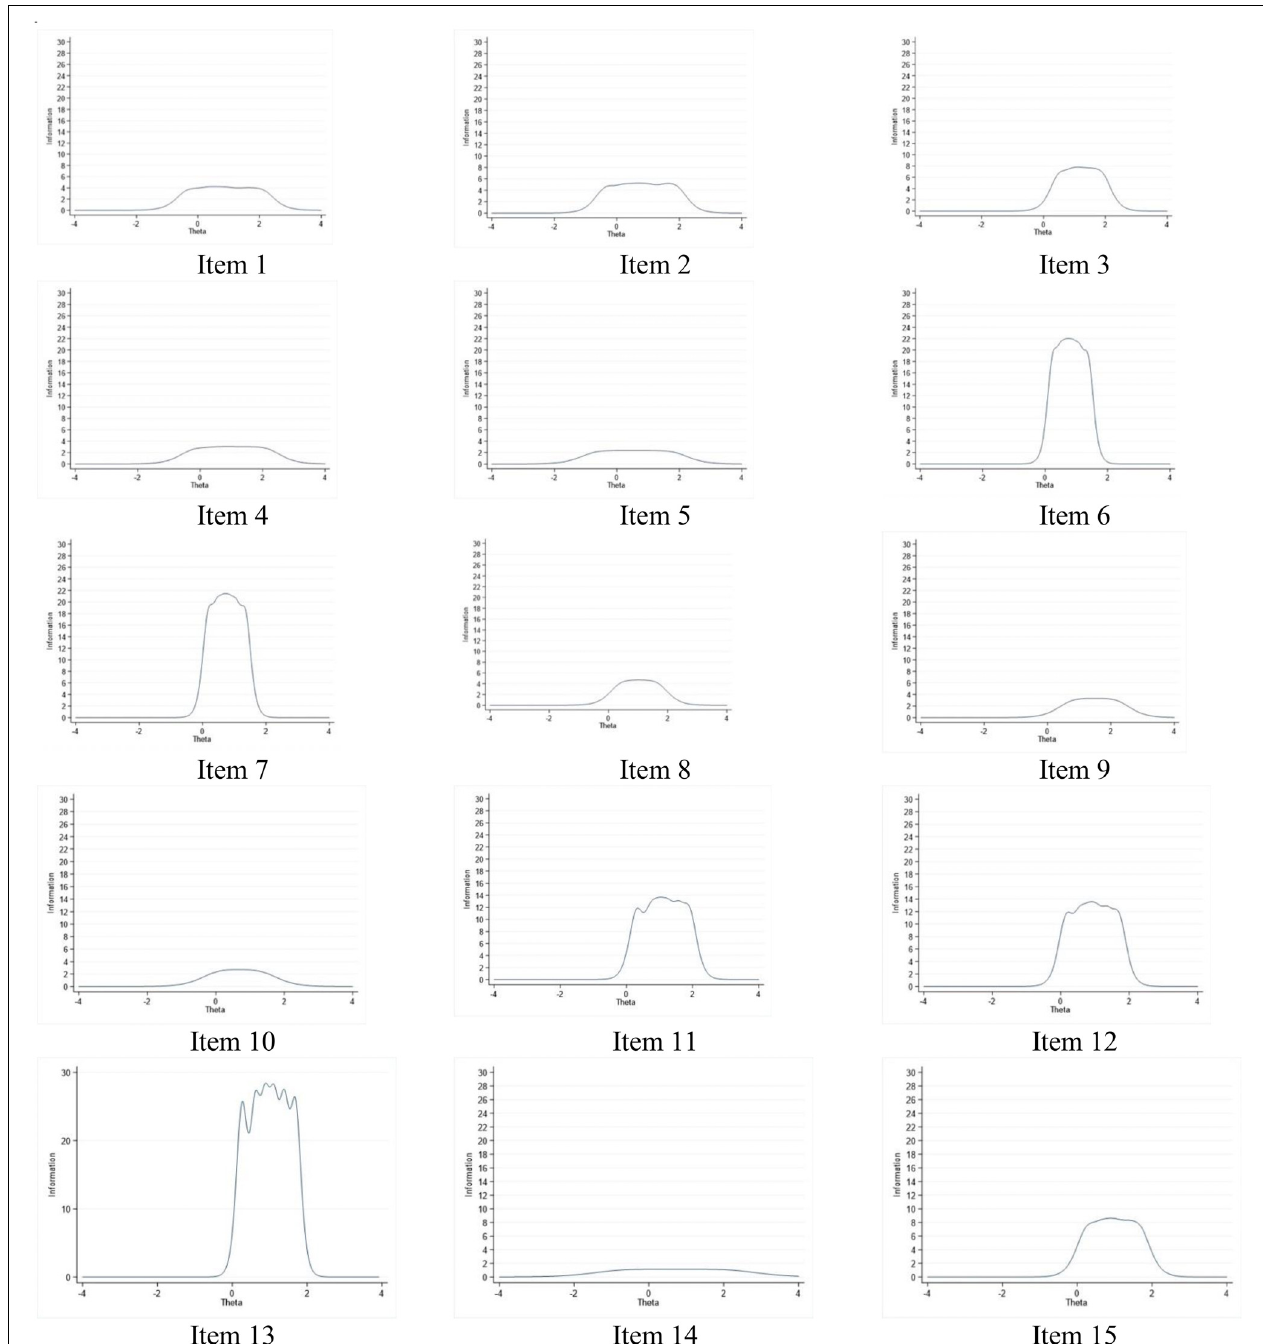
FIGURE 1 | Item information curves for the 15 items of ASR-YWMS starting from (top left) item 1 to (bottom right) item 15.